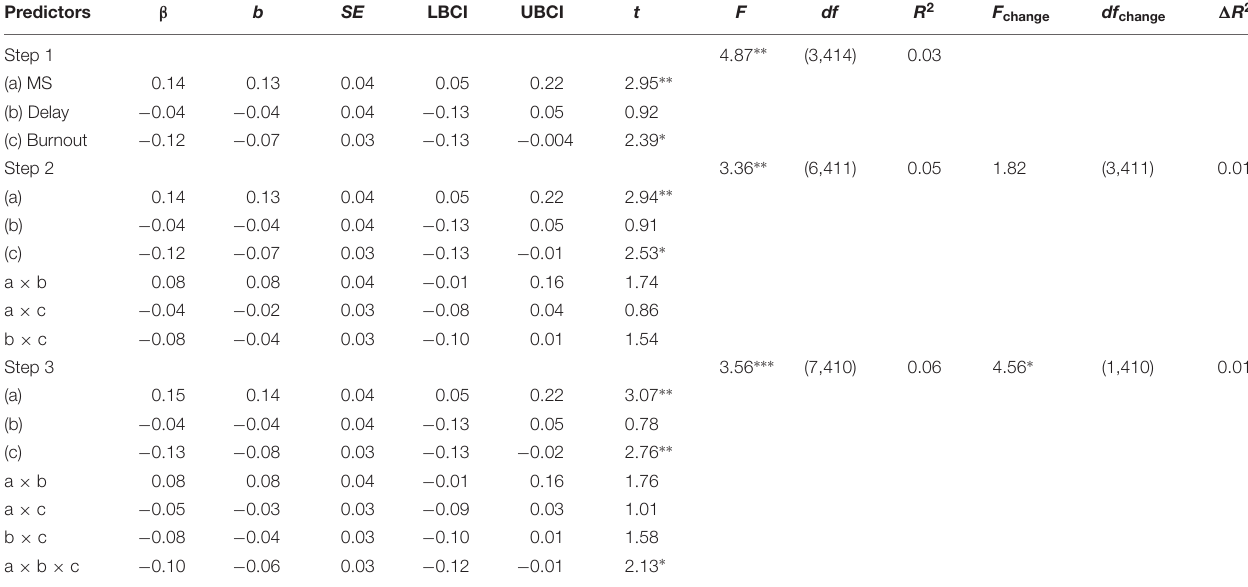
TABLE 2 | Hierarchical regression analysis, dependent variable: work self-efficacy ( N = 418). Predictors